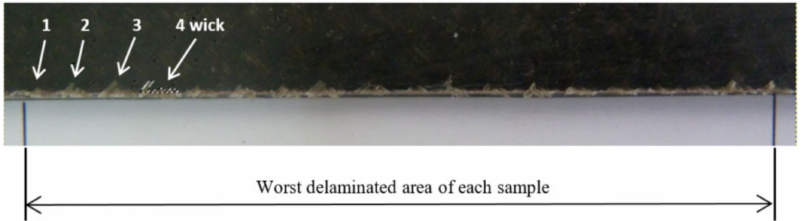
Figure 2. Evaluated laminate length (L).